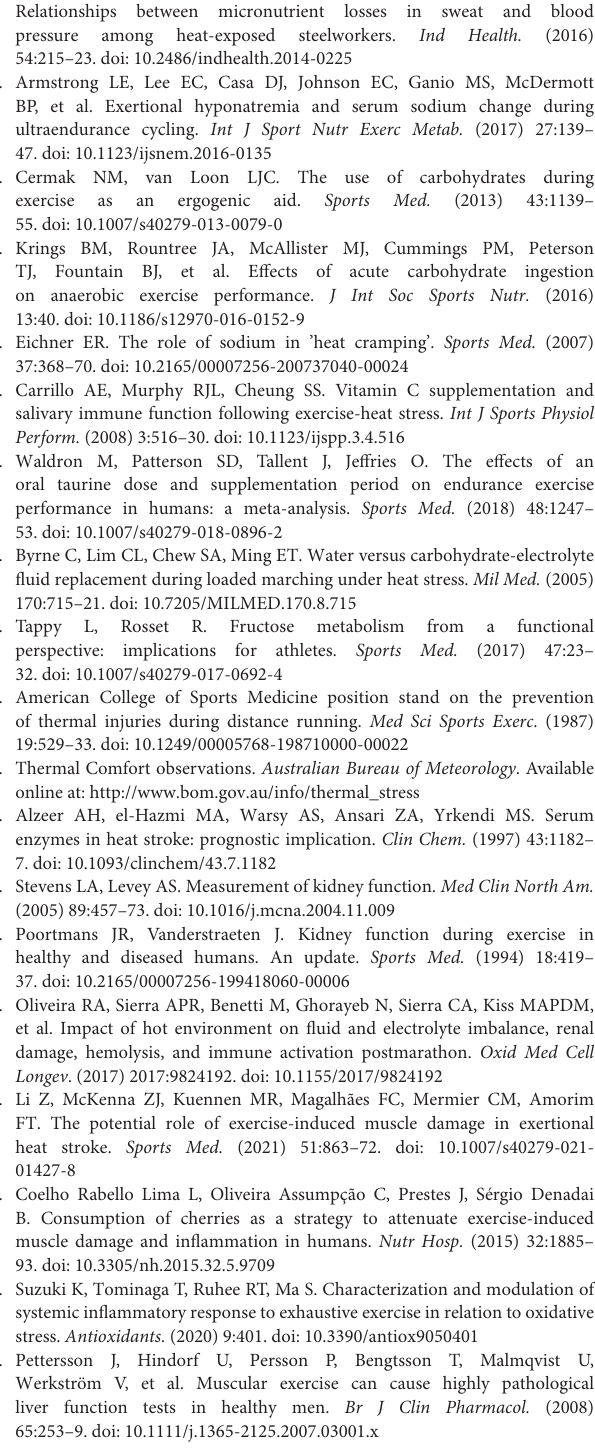
Supplementary Table 2 | Biochemical parameters of participants in the single-shot supplement trial at baseline. Data are presented as the means ±